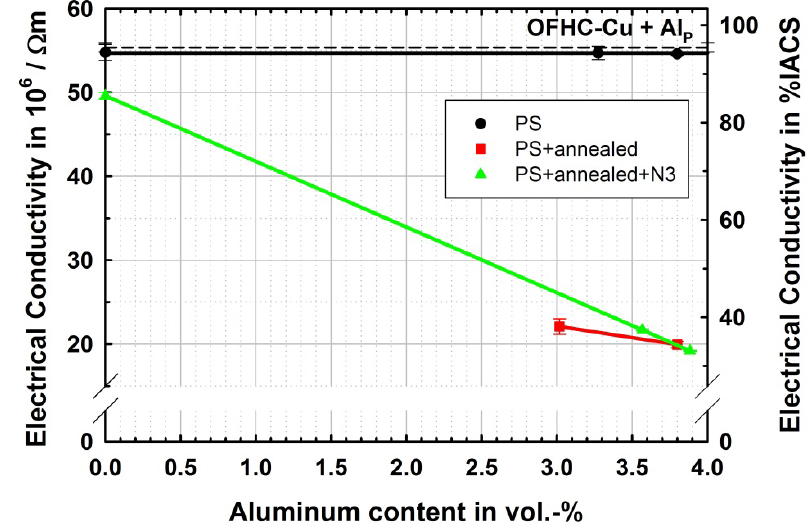
Figure 7. Electrical conductivity of the copper based materials in different microstructural states depending on the aluminum content. The dashed line symbolizes conductivity of OFHC-Cu in CG